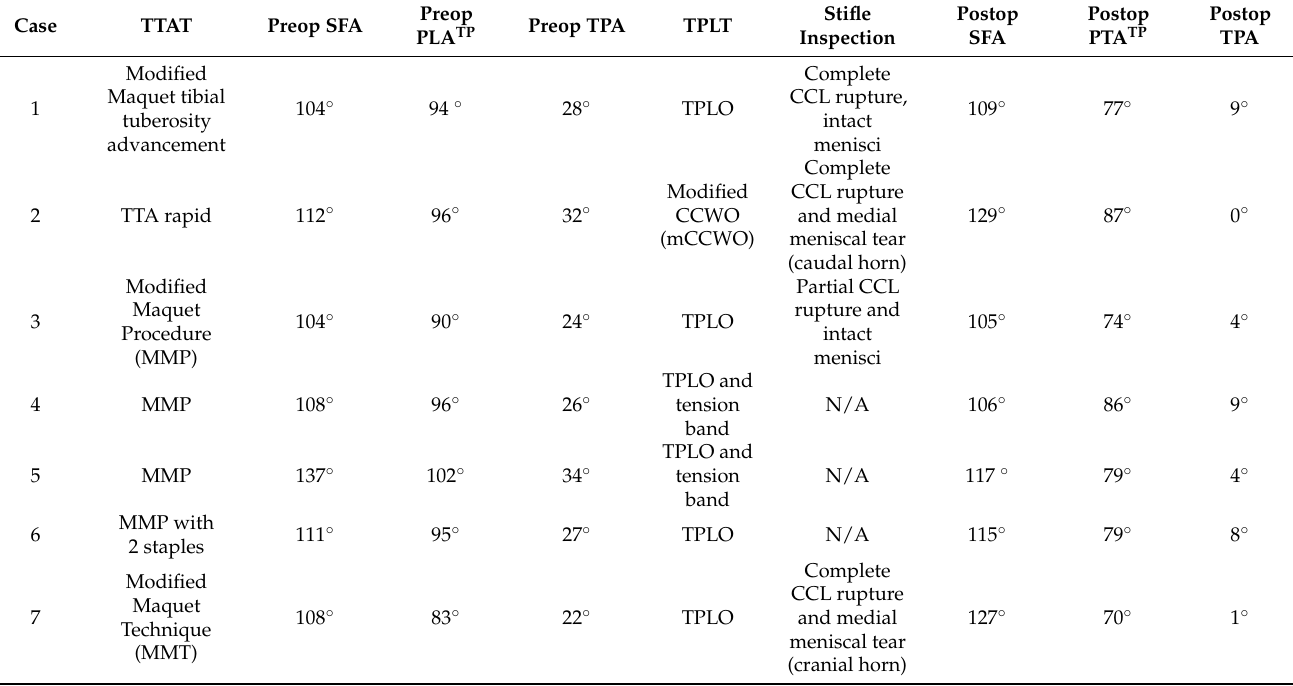
Table 2. Index surgeries, preoperative measurements, revision surgeries and postoperative